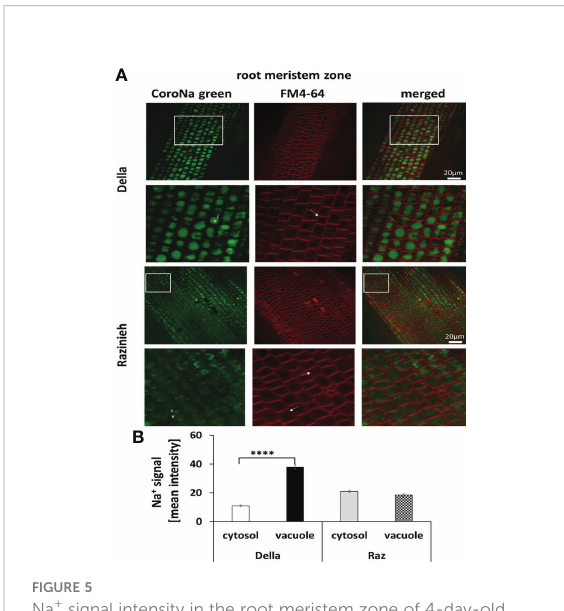
FIGURE 6 Na + signal intensity in the cytosol and vacuole in the root distal elongation zone of 4-day-old sorghum seedlings grown in darkness were treated with 100 mM NaCl for 24 h (A) Representative images of root distal elongation zone of Della and Razinieh genotypes, cells stained with CoroNa Green dye, and FM4- 64 dye. (B) Averaged values for Na + signal intensity in the cytosol and vacuole in the root distal elongation zone. Mean ± SE [ n = 98 (Della) and 53 (Razinieh)]. Asterisks indicate a statistically signi fi cant difference between treatment and corresponding control, as determined by Student ’